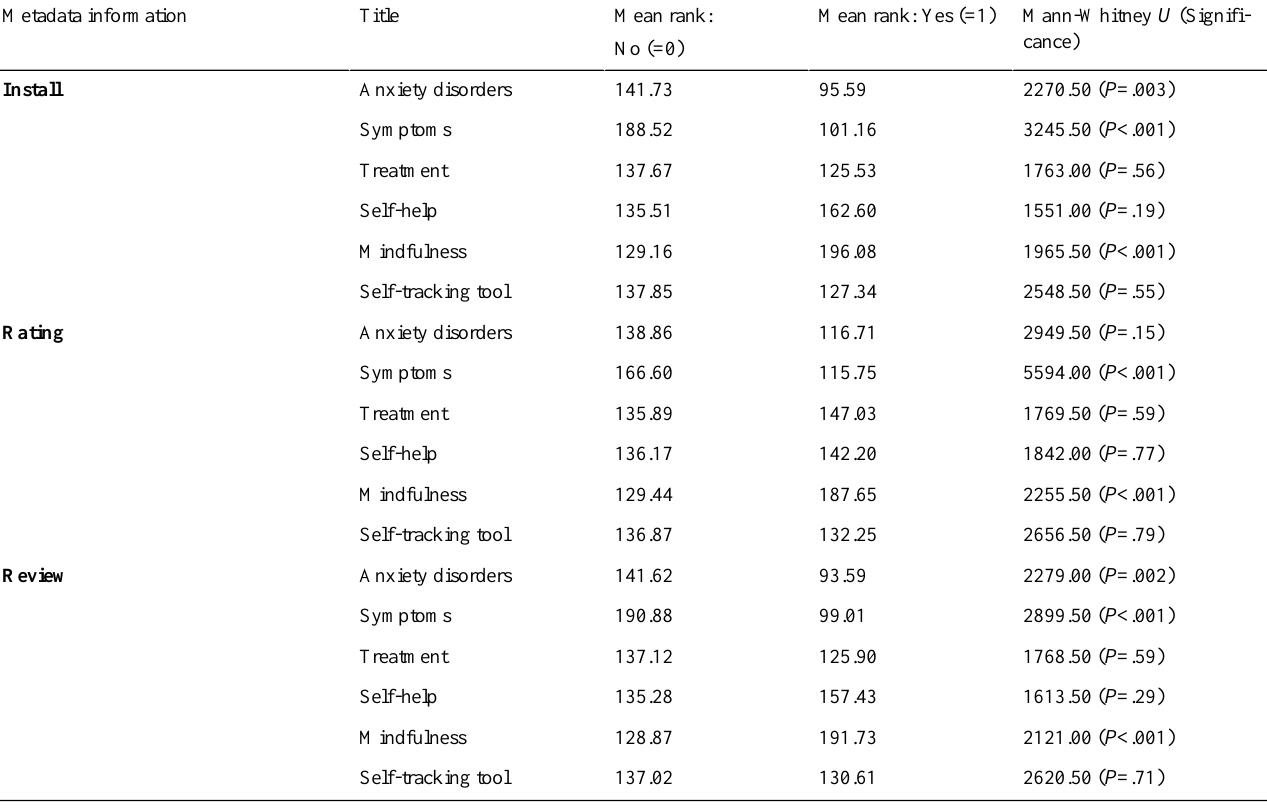
Table 5. Nonparametric Mann-Whitney test of installs, ratings, and reviews by types of